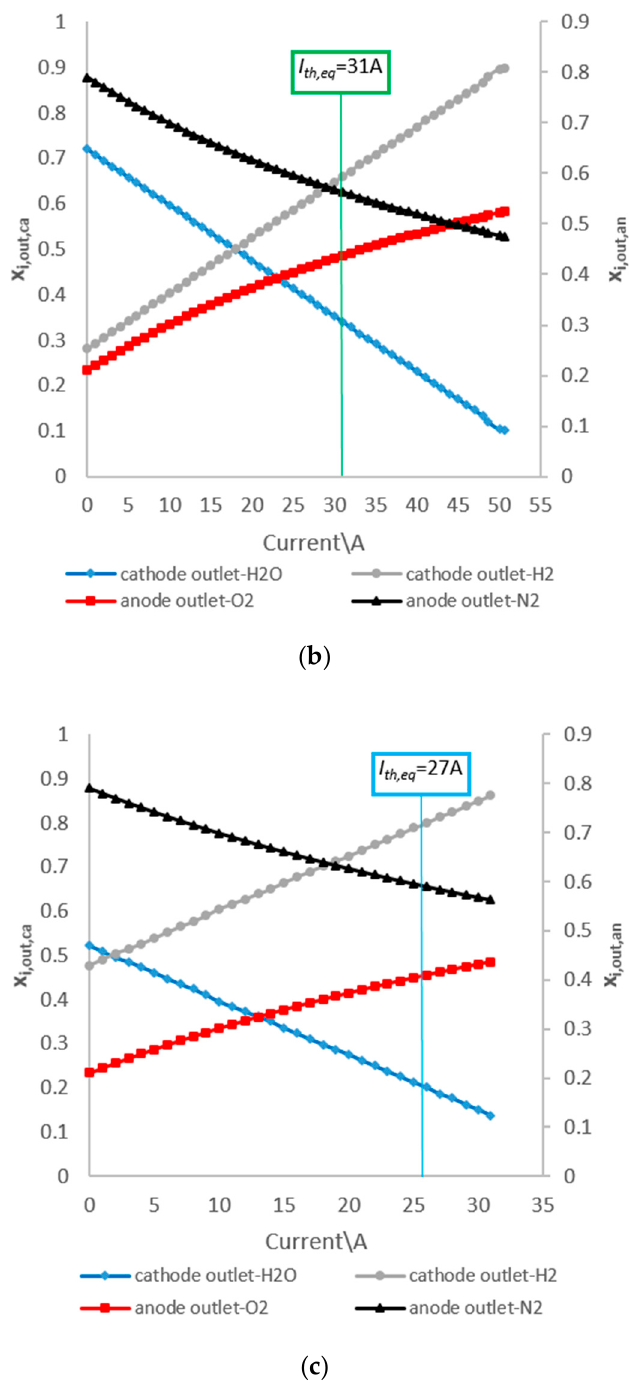
Figure 9. Trends of anode and cathode exhaust gas composition for the SOE stack fed by the steam mixtures ‘a’ ( a ), ‘b’ ( b ) and ‘c’ ( c ) and by air at varying the stack current.